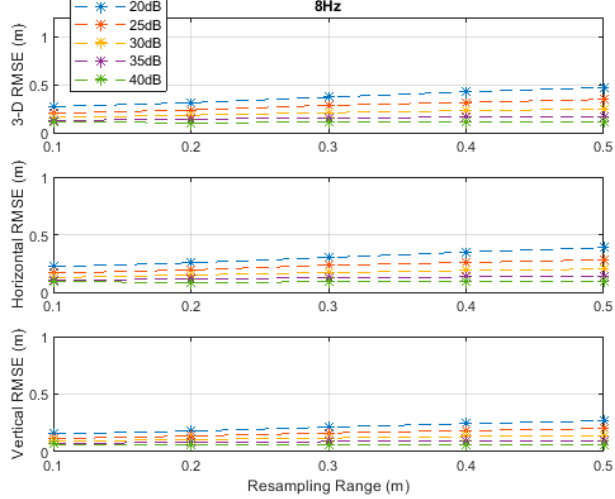
Sensors 2019 , 19 , x FOR PEER REVIEW Figure 4. RMSE results along the 3D linear path at a measurement update rate of 4 Hz.